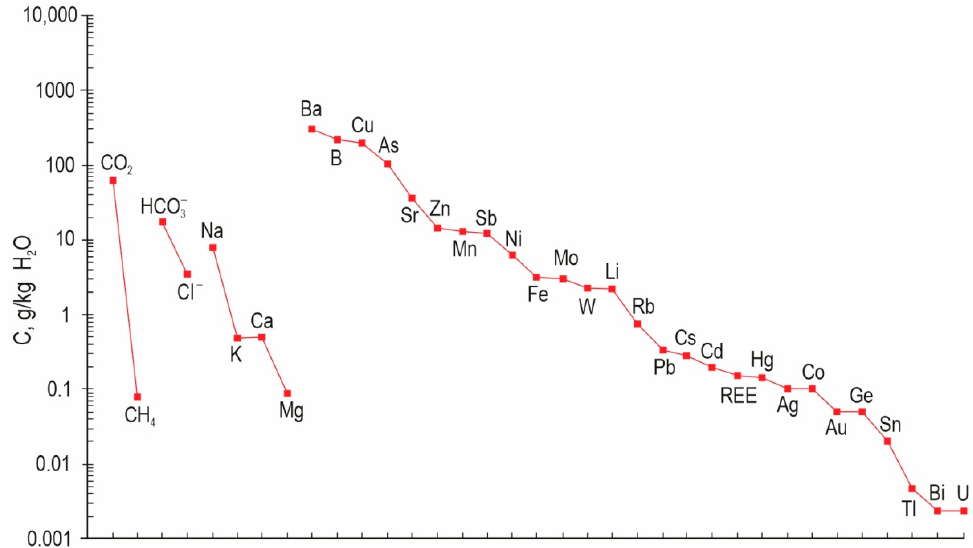
Figure 11. The average chemical composition of the Ulug-Sair ore occurrence fluid.